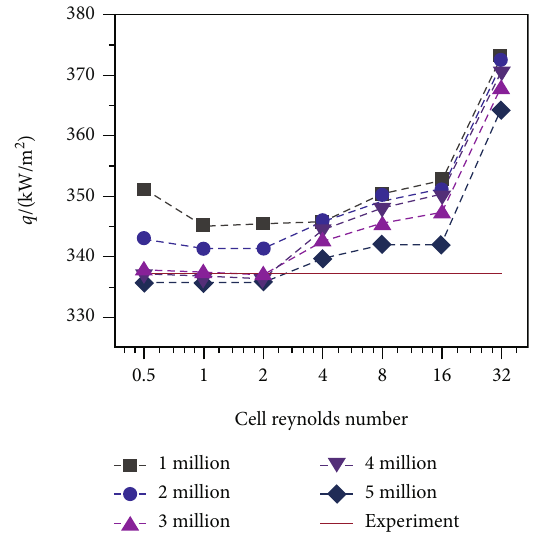
Figure 7: Heat fl ux of stagnation point with cell Reynolds number.